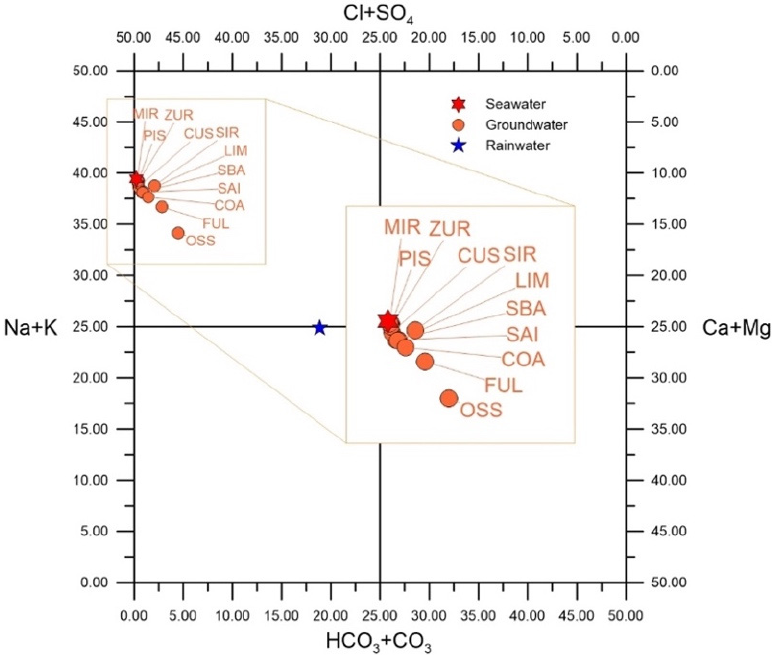
Figure 5. Plot of the average chemical composition of Stromboli groundwater in the Langelier– Ludwig diagram.